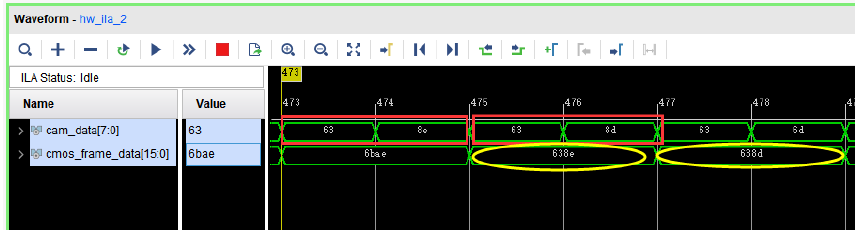
Figure 3. Comparison of results before and after bit splicing.